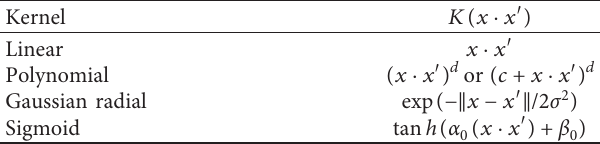
Table 10: Formulation of kernel